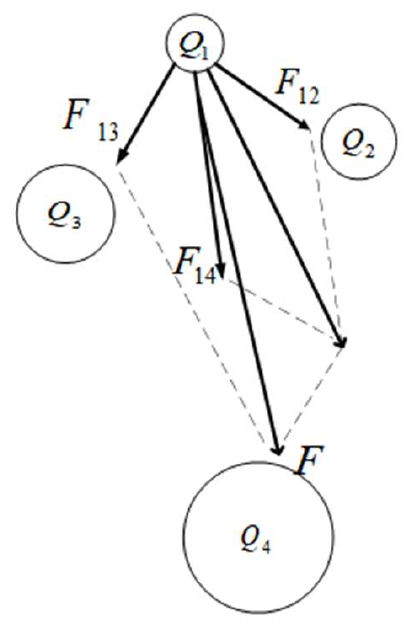
Figure 1. A schematic diagram of the force on the charged particles.